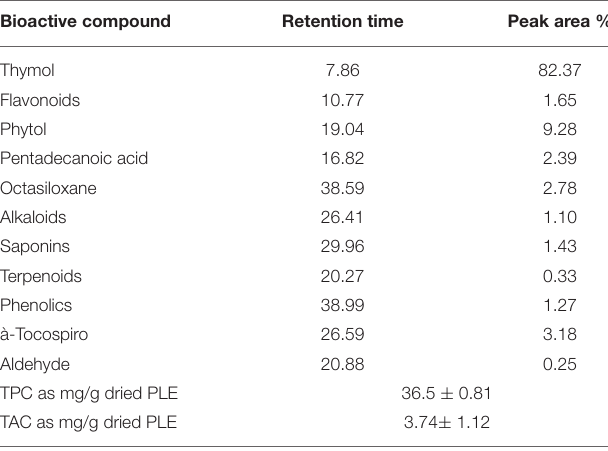
TABLE 4 | The gas chromatography/mass spectrometry analysis of the main bioactive compounds found in paulownia leaf extracts